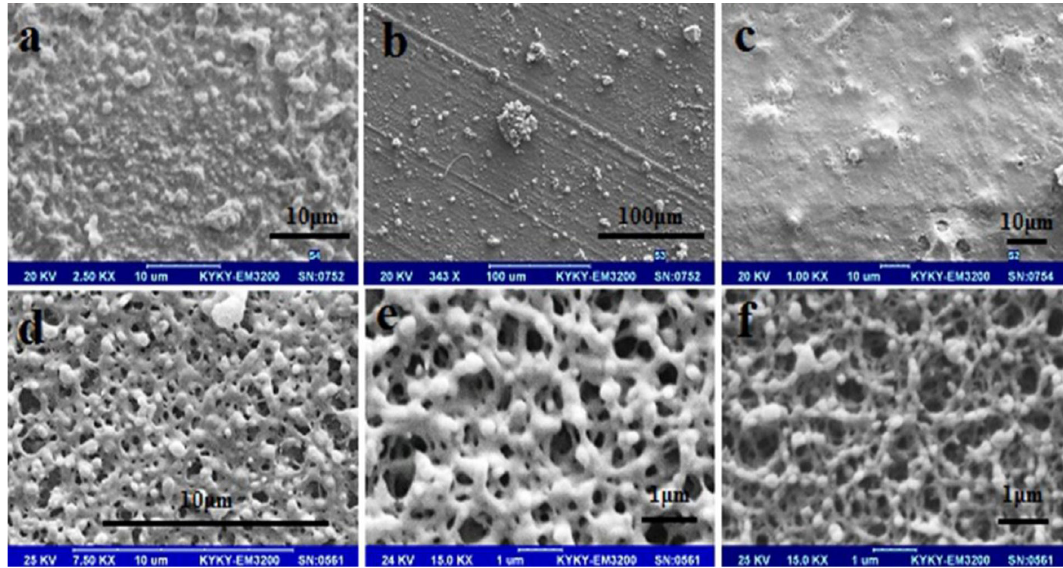
Fig. 4. SEM images of PLGA/BSA nanocapsules at voltage=10kV, nozzle–collector distance=10cm, flow rate 0.1 µl/ min: (a) PLGA/BSA ratio= 0.45/0.05 w/v (b) PLGA/BSA ratio= 0.4/0.1 w/v (c) PLGA/BSA ratio= 0.25/0.25 w/v. And flow rate 0.2 µl/ min: (d) PLGA/BSA ratio= 0.45/0.05 w/v (e) PLGA/BSA ratio= 0.4/0.1 w/v (f) PLGA/BSA ratio= 0.25/0.25